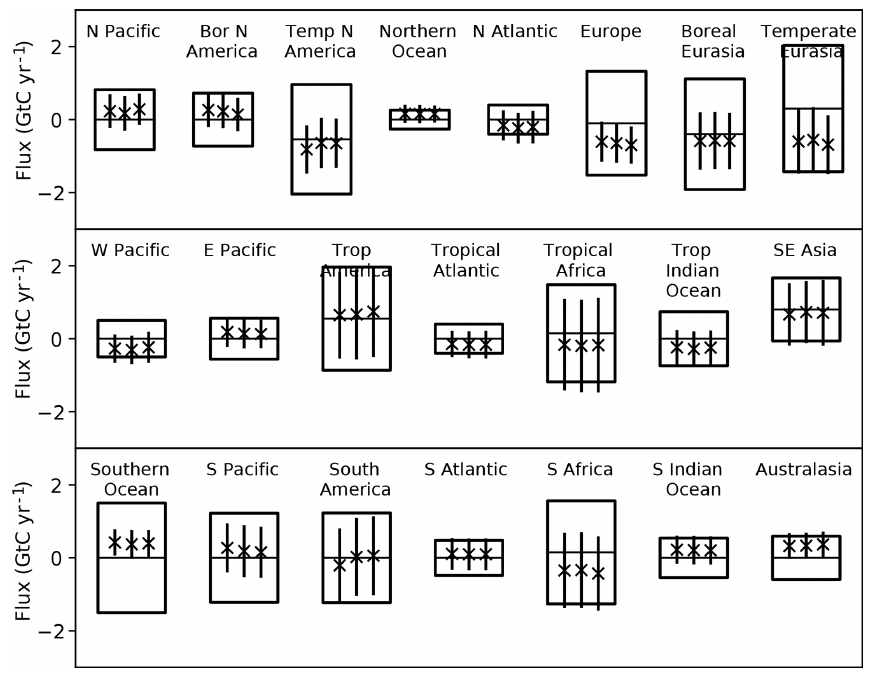
Figure 5. Prior and posterior uncertainties for regional fluxes from TransCom following Gurney et al. (2002). The centre line of each box shows the prior estimate of the mean while the box limits show the ± 1 σ uncertainties. The three bars show the mean (marked with “x”) and ± 1 σ uncertainty denoted by the length of the bar. The uncertainty is that of the ensemble including both the uncertainty for each model and the dispersion among model means. The left bar shows the equally weighted case for the full network, the middle bar the equally weighted case with the cross-validation stations removed and the right bar the L -weighted case for the cross-validation